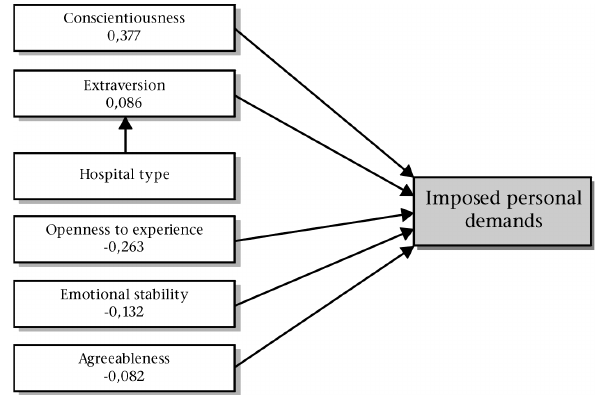
Figure 9: Biographical variables and personality variables as